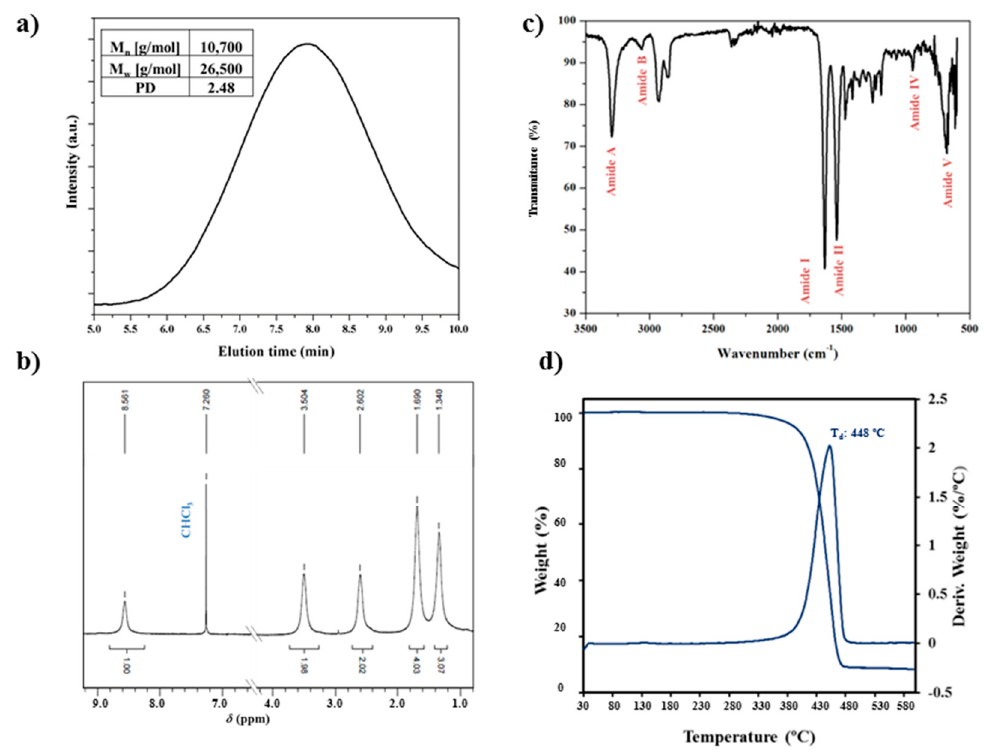
Figure 1. GPC chromatograph ( a ); FTIR spectrum ( b ); 1 H NMR spectrum ( c ); and TGA/DTGA thermogravimetric curves ( d ) of synthesized nylon 4 9.